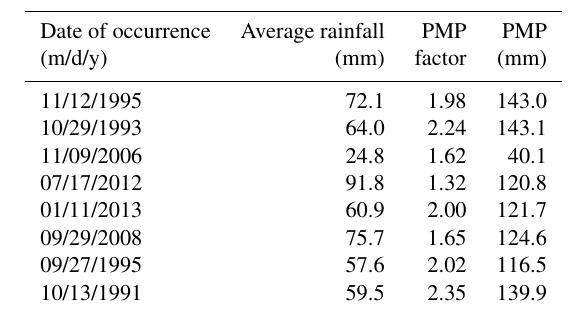
Table 5. The PMP values estimated using the physical approach for selected storms in the study area.